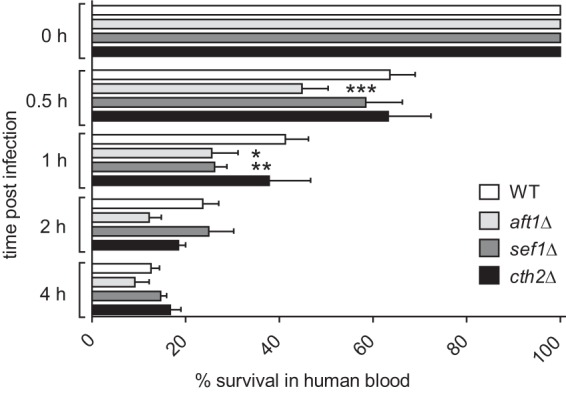
Aft1 and Sef1 are needed for survival in human blood. Human blood was infected with the C. glabrata WT, aft1Δ, sef1Δ, and cth2Δ strains, and survival at 37°C was determined by CFU plating after the indicated time points (0 h, 0.5 h, 1 h, 2 h, and 4 h). Data are shown as percent survival of the WT at 0 h (means ± standard deviation). Data represent results of a paired one-way analysis of variance (ANOVA) of comparisons to WT results from the same time point (*, P < 0.05; **, P < 0.01; ***, P < 0.001).